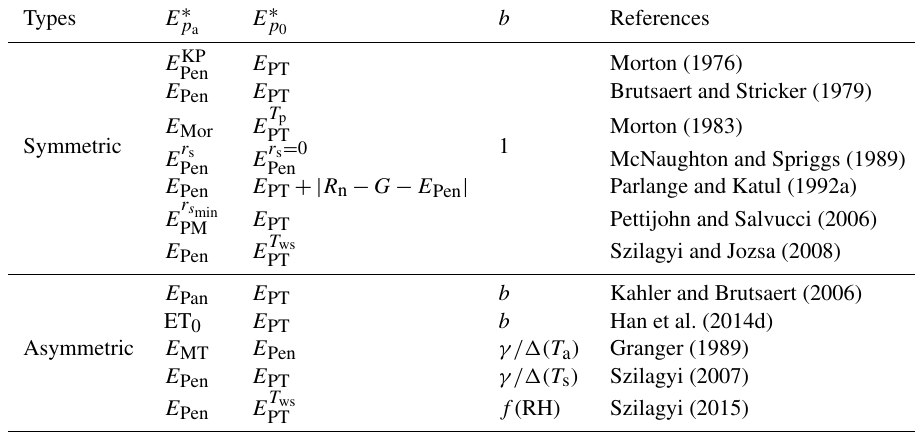
and E p in different linear CR a 0